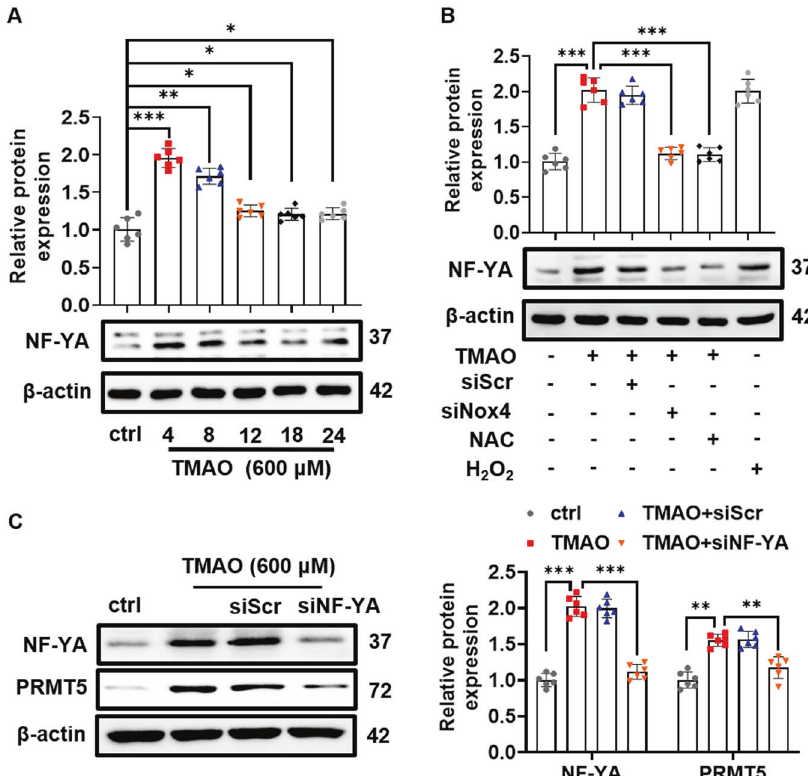
Fig. 7 NF-YA is responsible for TMAO-induced PRMT5 expression. A VSMC were treated with TMAO (600 μ M) for indicated periods. Representative blots and quantitative analysis of NF-YA. The protein expression level was normalized to β -actin. B VSMC were transfected with scrambled siRNA (siScr) or Nox4 siRNA (siNox4) and then stimulated with TMAO (600 μ M) for 24 h. Representative blots and quantitative analysis of NF-YA. The protein expression level was normalized to β -actin. C VSMC were transfected with NF-YA siRNA (siNF-YA) or siScr and then stimulated with TMAO (600 μ M) for 24 h. Representative blots and quantitative analysis of NF-YA and PRMT5. The protein expression level was normalized to β -actin. Data shown are means ± SD, n = 6 per group from three independent experiments. * P < 0.05, ** P < 0.01, *** P < 0.001 using a one-way ANOVA followed by Tukey ’ s post hoc test.